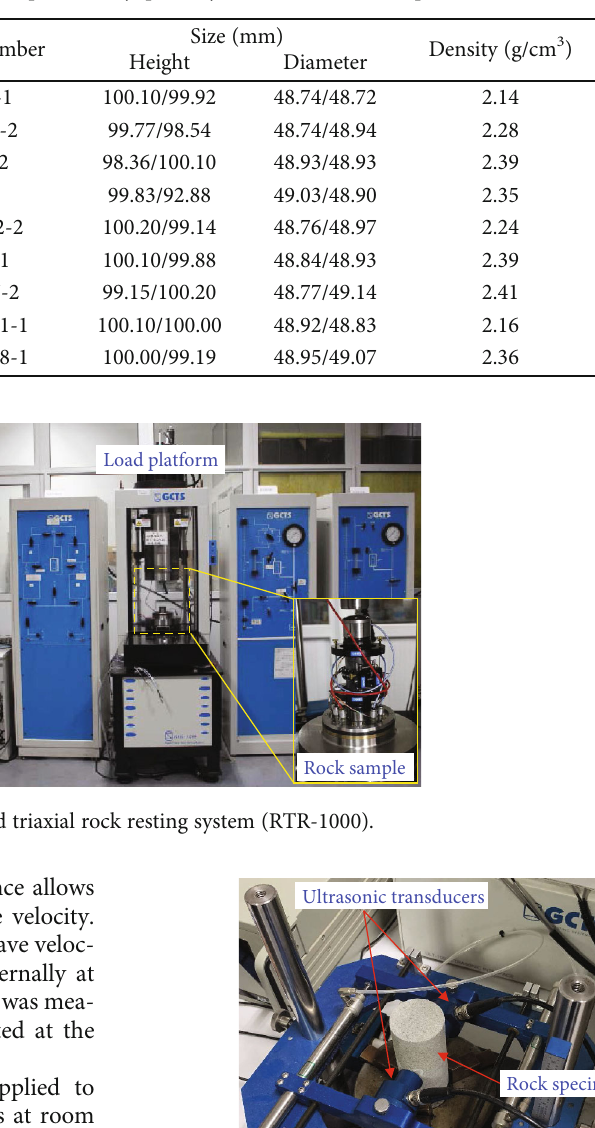
Table 1: Average buried depth, density, porosity, and size of rock samples.